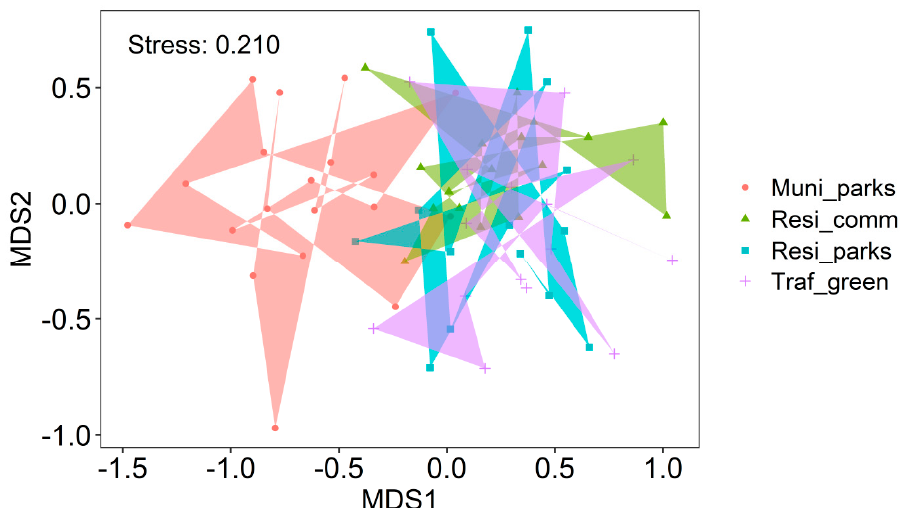
Figure 3. NMDS analysis of avian community structure in different habitat types during the breeding season (Bray–Curtis similarity, original data; stress = 0.210). The figure delineates species matrix distance across sites and habitat types, and the spatial relationship between species matrices within different habitat types. Due to the cluster results for the two phenological phases being very similar, we only displayed those for the breeding season. Table 2. Multi-response Permutation Procedures for analysis for all combinations of habitat types. Group